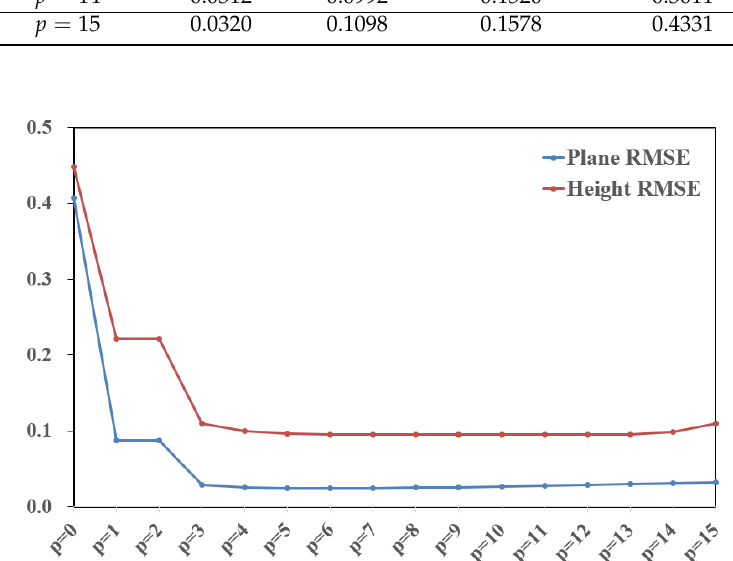
Figure 10. The RMSE as a function of the different parameters in the exponential kernel function. To analyse the parameter of the Gaussian kernel function, we set σ 2 = 2 0 , 2 − 1 , ..., 2 − 7 , and recorded the RMSE and the maximum residual in Table 7, where the plane and height accuracies are listed. In addition, the RMSE, as a function of the parameter, is depicted in Figure 11. The plane and height errors decreased when the parameters ranged from 0 to − 7. However, a larger RMSE and larger maximum residual was obtained when σ 2 = 2 − 7 , because the effect of the weighting matrices on the distance between points was reduced when σ 2 was very small. Thus, σ 2 = 2 − 6 was found to yield better accuracy in the Gaussian kernel